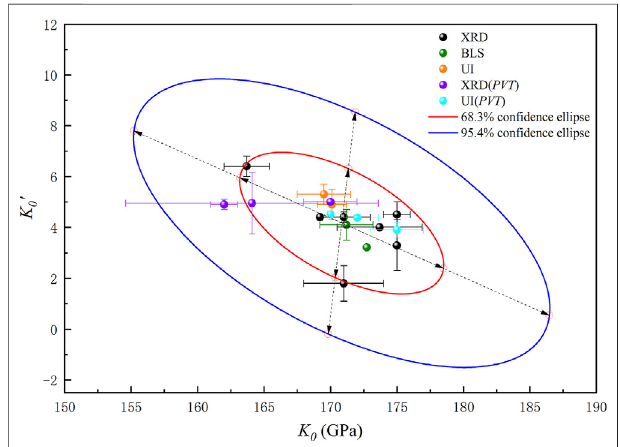
FIGURE 2 | Con fi dence ellipses of K 0 and K ′ for pyrope from previous studies.